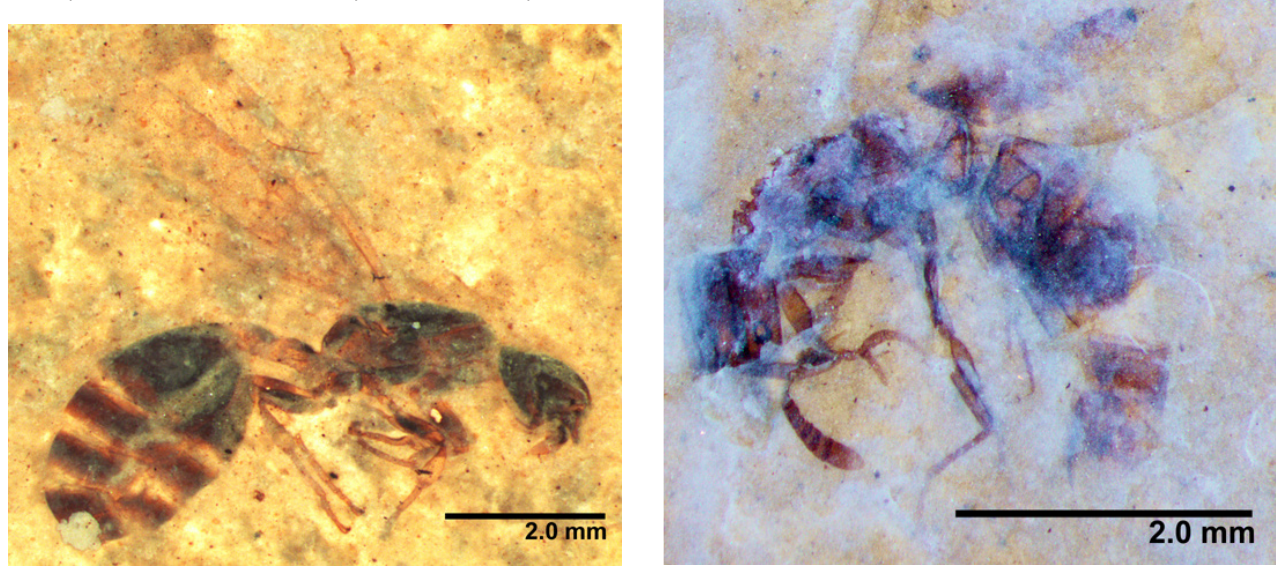
Fig 11 . Holotype queen, Ponerites kishenehne (USNM# 609604). Fig 10 . Holotype queen, Solenopsites abdita (USNM#